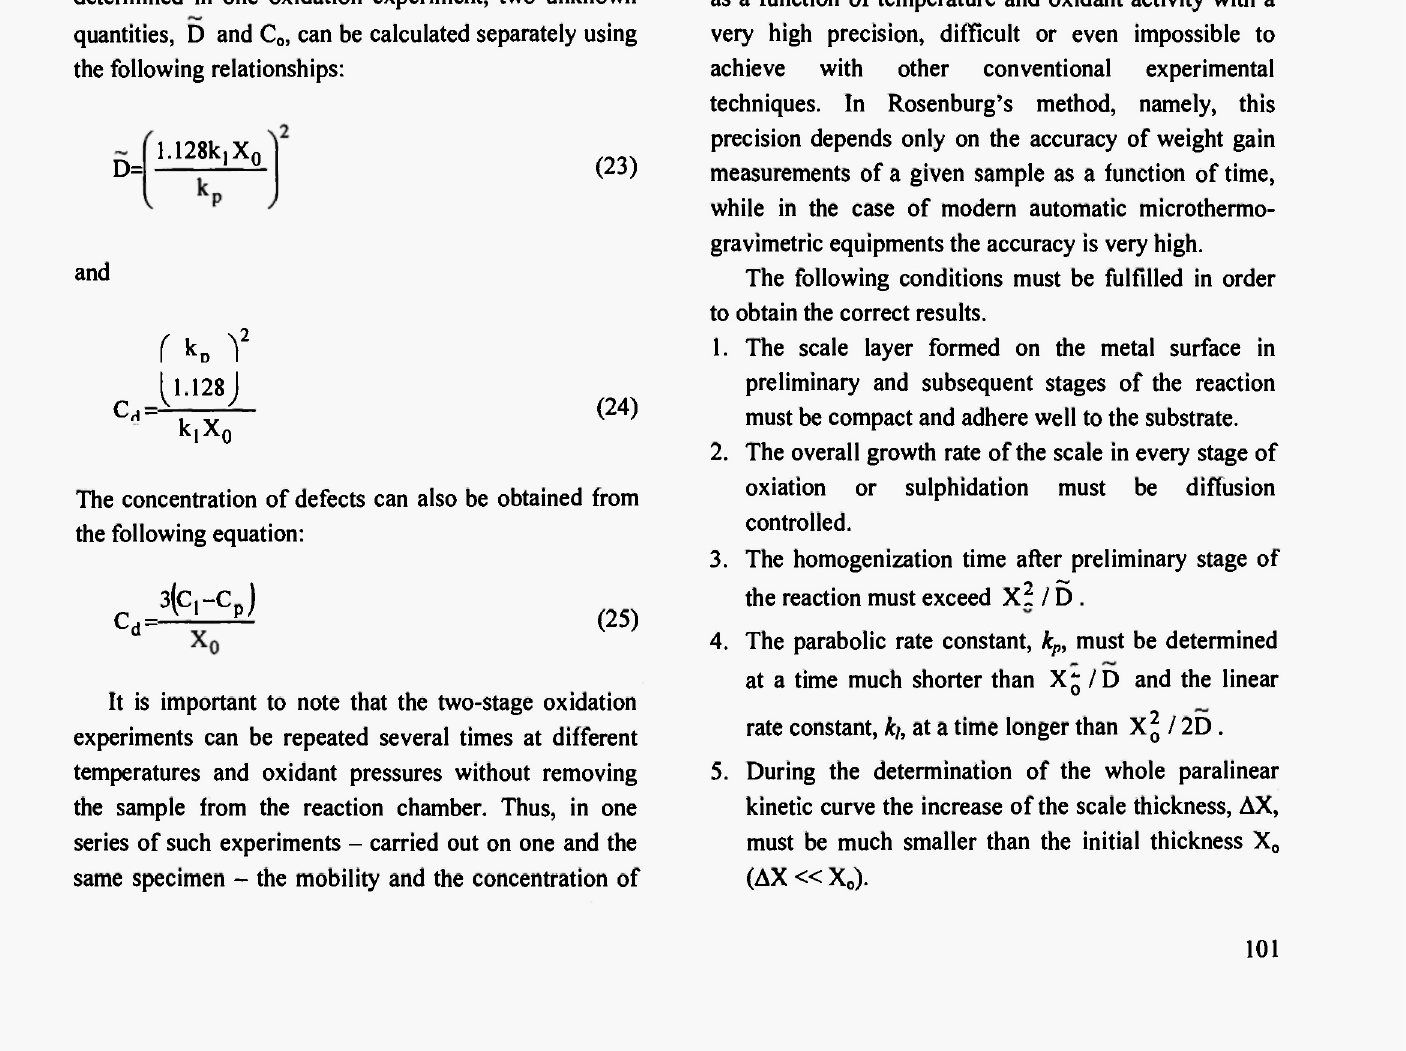
Fig. 15: Rosenburg's paralinear kinetic curve